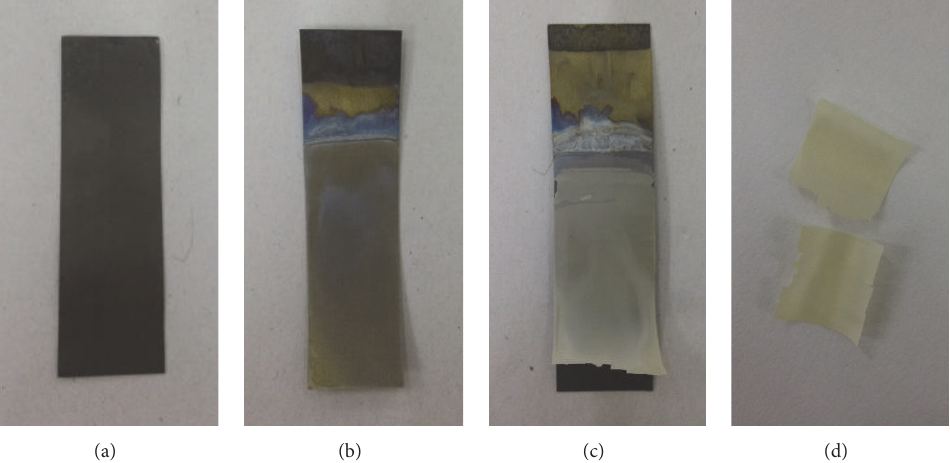
Figure 1: The appearance of TiO 2 nanotube arrays in different stages of the preparation process: (a) Ti foil before treatment, (b) TNT arrays after the first anodization, (c) TNT arrays after second anodization, and (d) TNT arrays film eventually obtained.